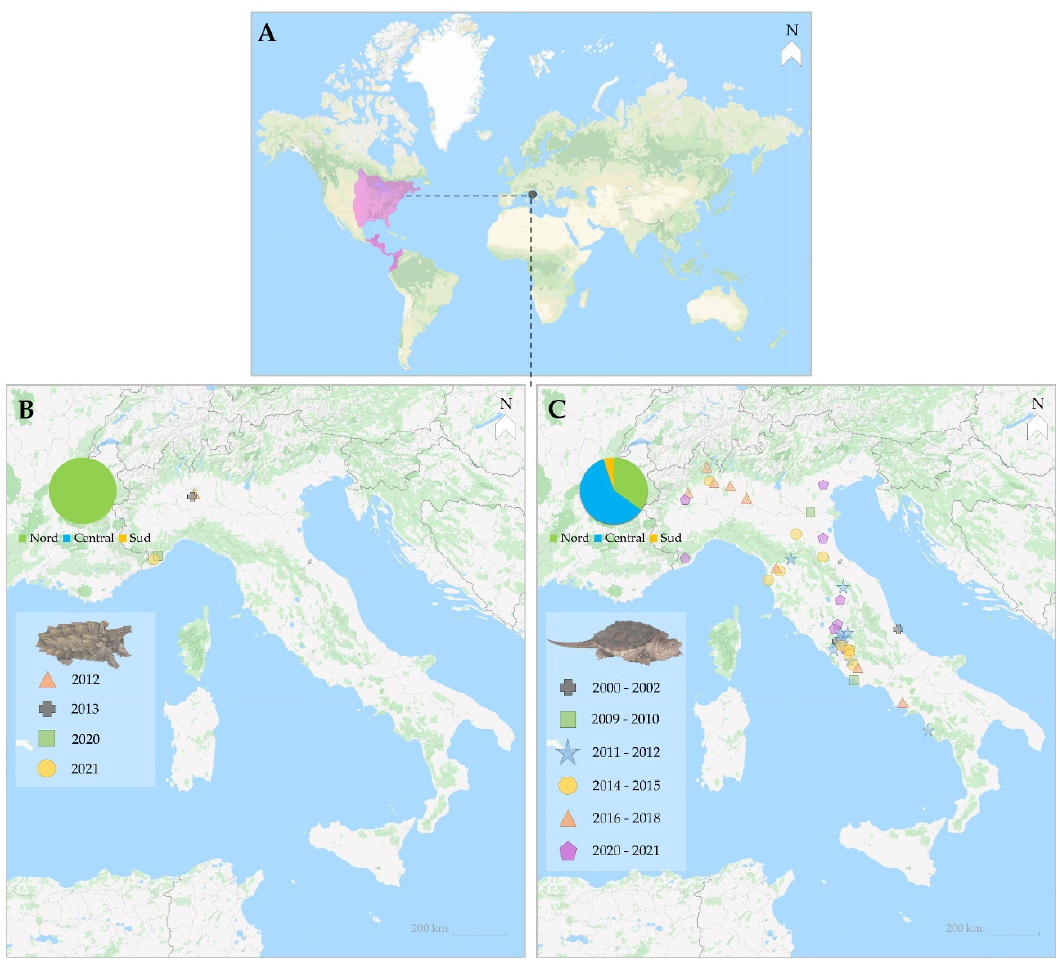
Figure 1. Native distribution (in fuchsia ( A )) and distribution of Chelydridae in aquatic environments in Italy from 2000 to 2021 (( B ), alligator snapping turtle ( Macrochelys temminckii ); ( C ), snapping turtle ( Chelydra serpentina )).